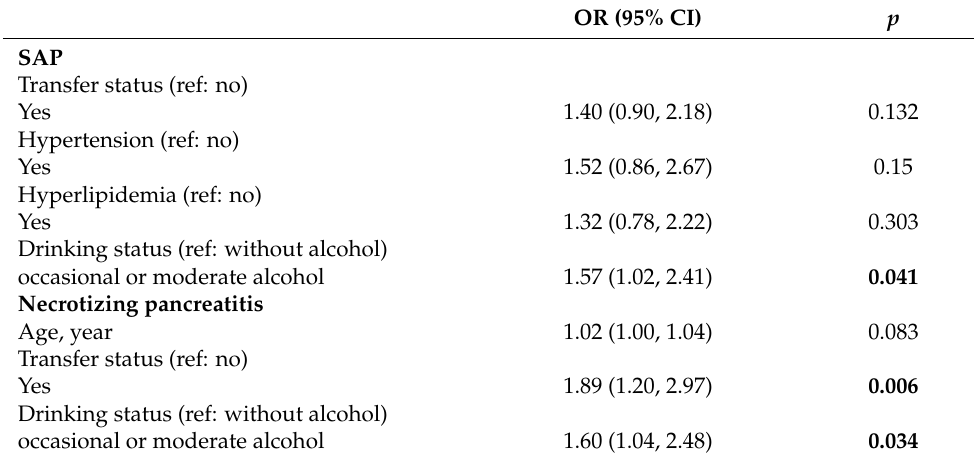
Table 4. Multivariate logistic regression analysis for the association of patients’ demographic charac- teristics with the risk of SAP and necrotizing pancreatitis in OMA group and WA